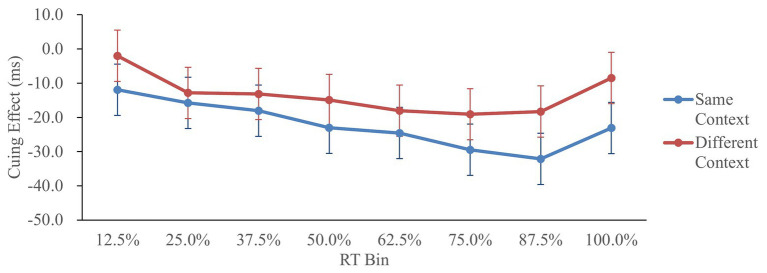
Cuing effect in Experiment 1, as a function of context and response time (RT) bin. Cuing effect = invalid RT − valid RT. Error bars represent the 95% confidence interval, based on the method of Jarmasz and Hollands (2009).